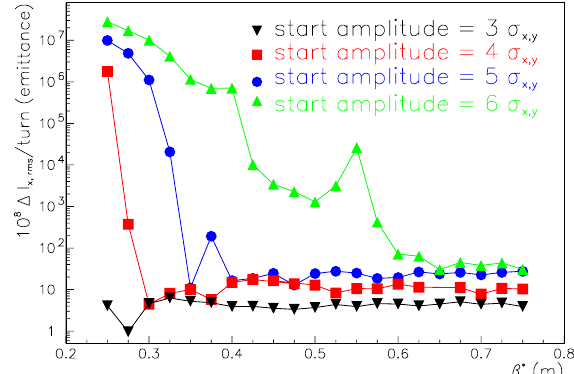
FIG. 17. (Color) The change of action variance per turn as . Along with b (cid:1) , the crossing angle is a function of b (cid:1) x , y x , y changed, so as to maintain a constant ratio u c (cid:2) u x , y . The starting amplitude in both planes varies from 3 to 6 s x , y . The vertical axis gives the variance in units of the design rms emittance times 10 2 8